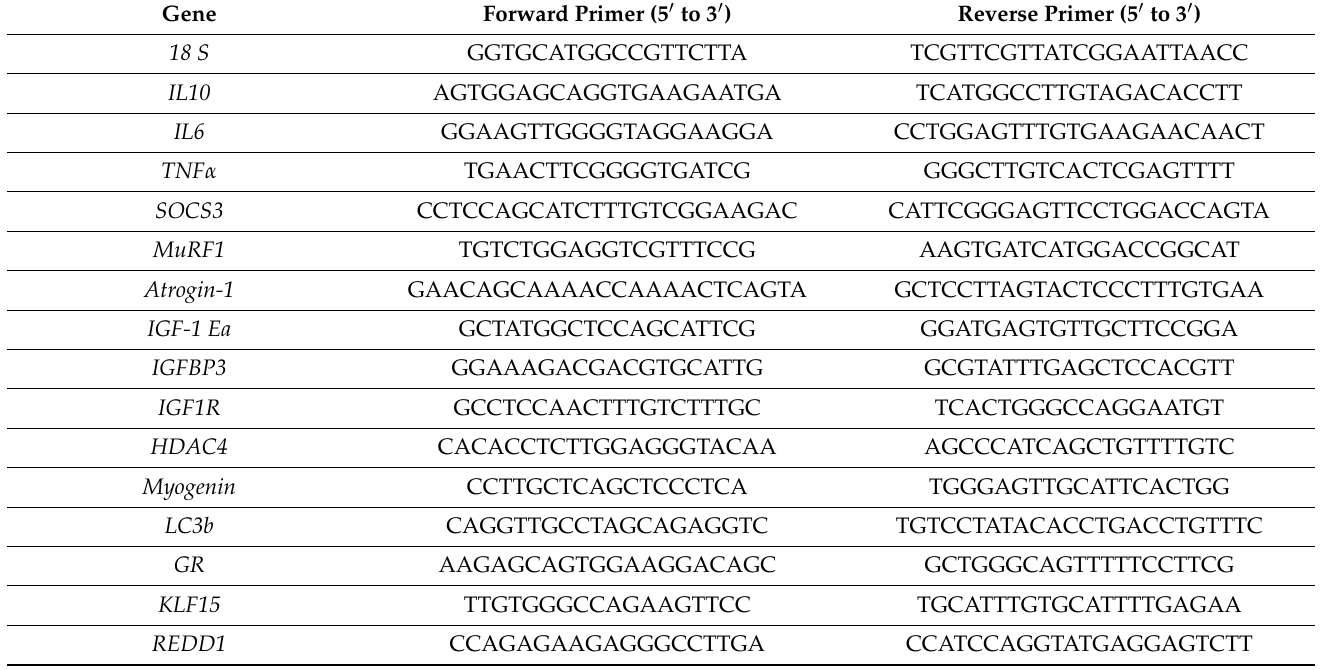
Table 2. Primers for mRNA